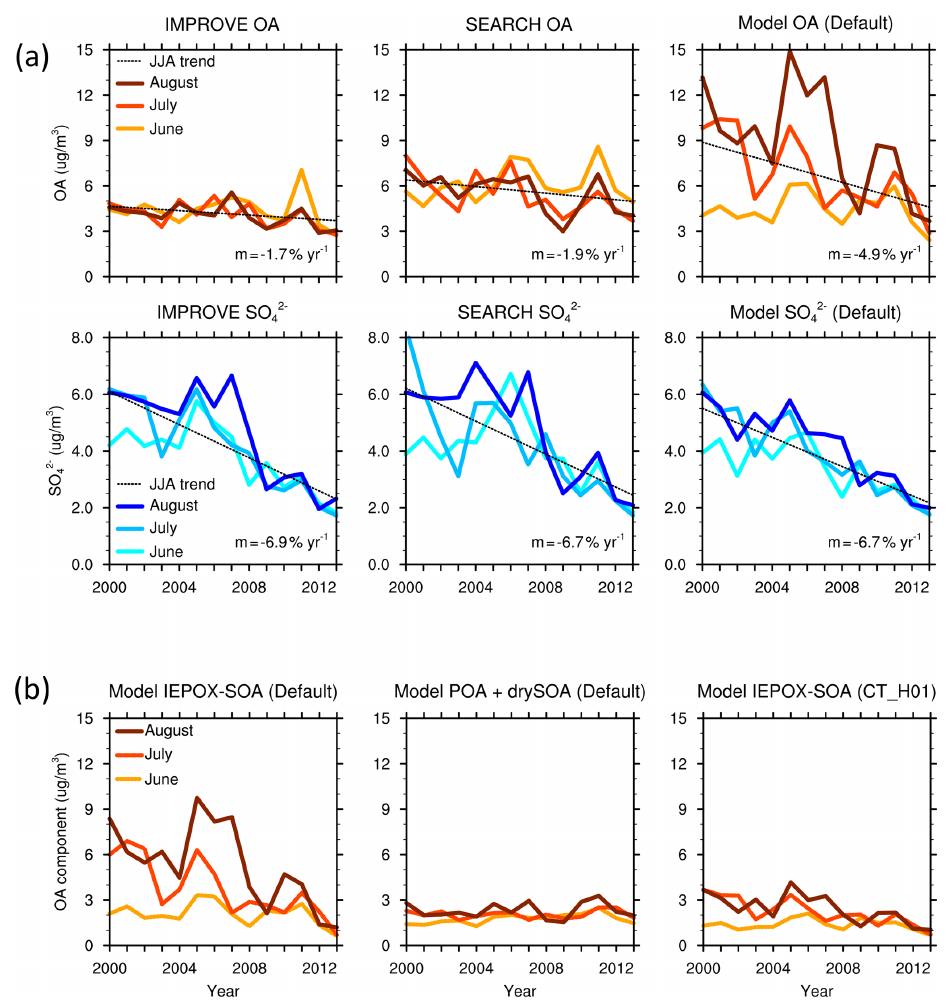
Figure 2. (a) Monthly surface OA and sulfate (SO 2 − ) concentration (µgm − 3 ) averaged over the southeast US from IMPROVE, SEARCH 4 and the default model. (b) Monthly surface concentrations of IEPOX SOA and the sum of POA and dry SOA from the default model, and IEPOX SOA from the CT_H01